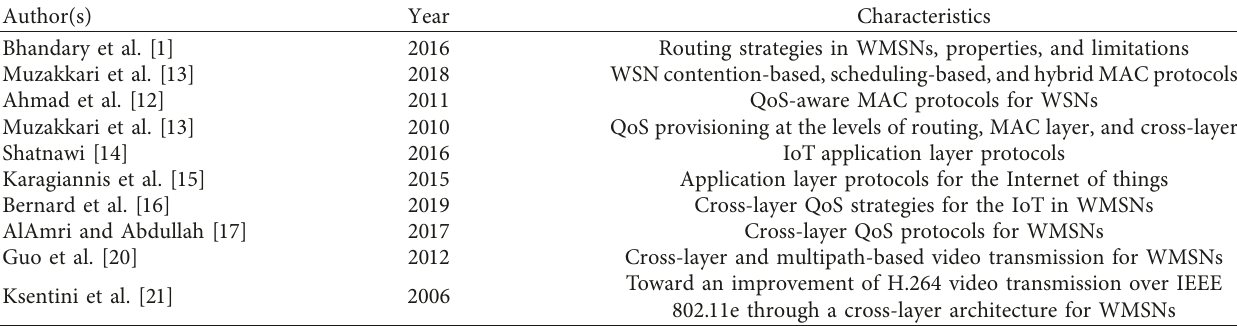
Table 1: Comparison of this survey with existing